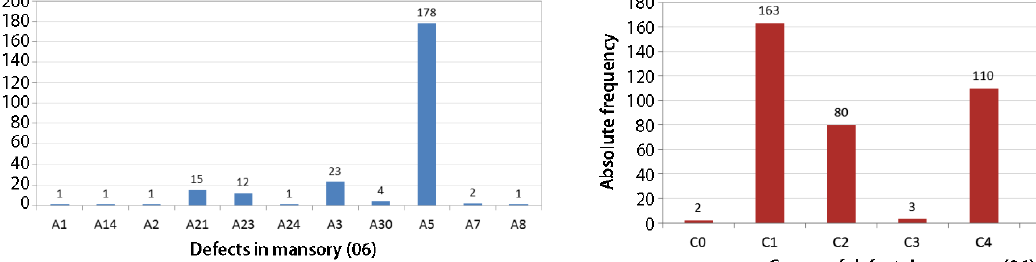
Fig. 16. Absolute frequency of the general groups of causes in masonry (06)